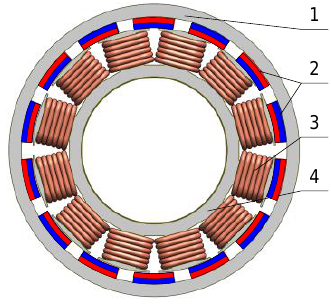
Figure 1. Overview of ERPMSM construction: 1, rotor; 2, permanent magnets; 3, concentrated winding; 4, stator.